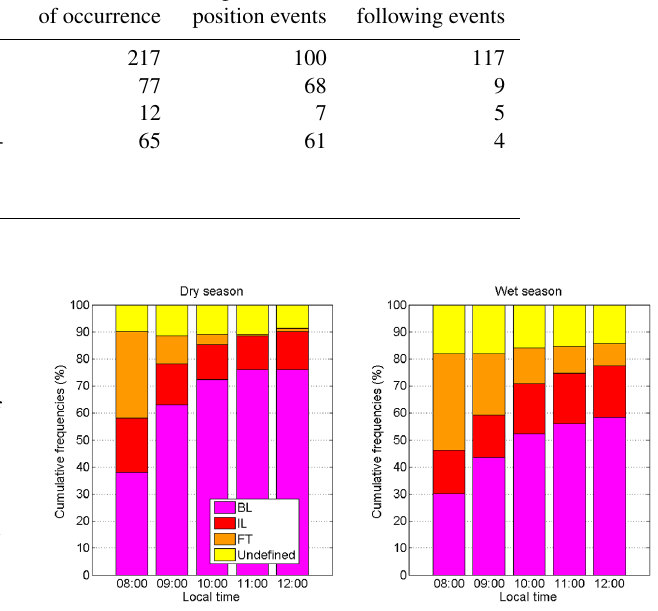
Figure 5. Statistics on the location of the station in the tropospheric layers (boundary layer, BL; interface layer, IL; and free troposphere, FT) between 08:00 and 12:00LT, separately for the dry and wet